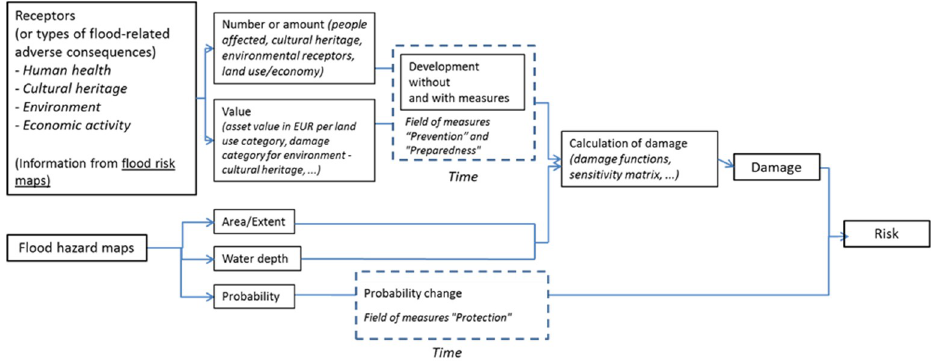
Figure 2. Overall risk analysis procedure [7,8].